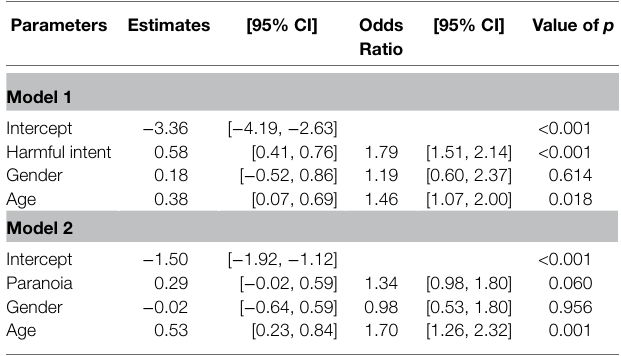
TABLE 2 | Results of logistic regression models that predicted the probability of a preemptive